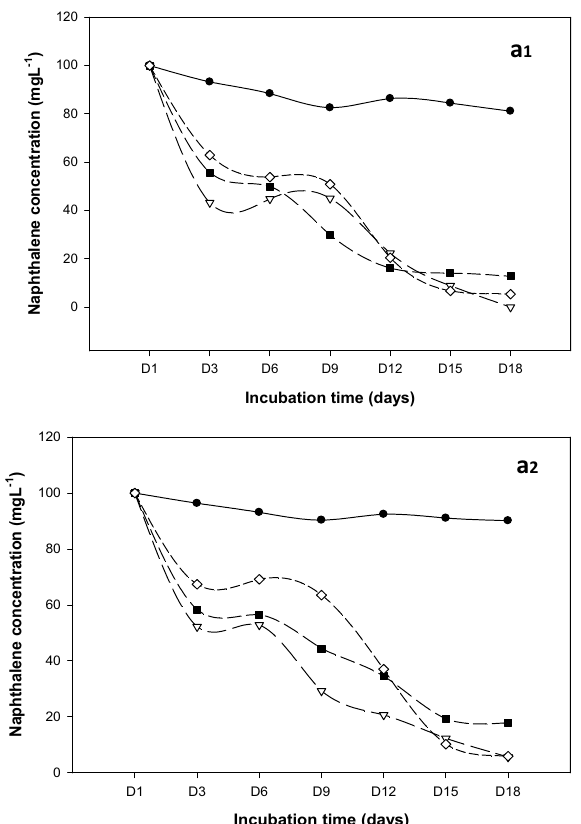
Figure 4. Naphthalene degradation curves at ( a1 ) 37 °C and ( a2 ) 25 °C; Control experiments (solid sphere), B. brevis (solid squares), P. mirabilis (diamond), and R. qinshengi (triangle).